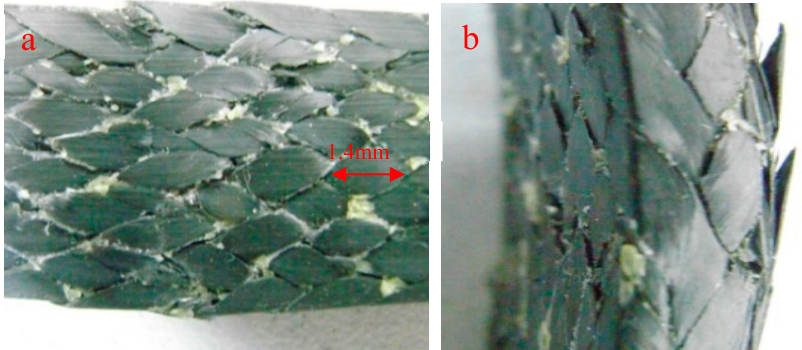
Figure 12. The bending fracture morphology of 3Dim–5Dir braided composites at 150 °C ( a ) at room temperature; ( b ) 150 °C 0.25 h.